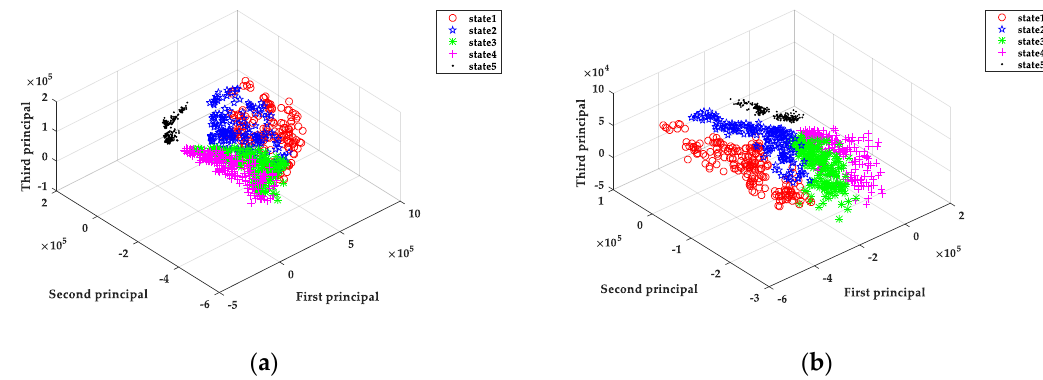
Figure 9. Three-dimensional visualization for the different tool wear states. ( a ) The original data principal component analysis visualizing picture. ( b ) The data processed by order analysis visualizing picture.